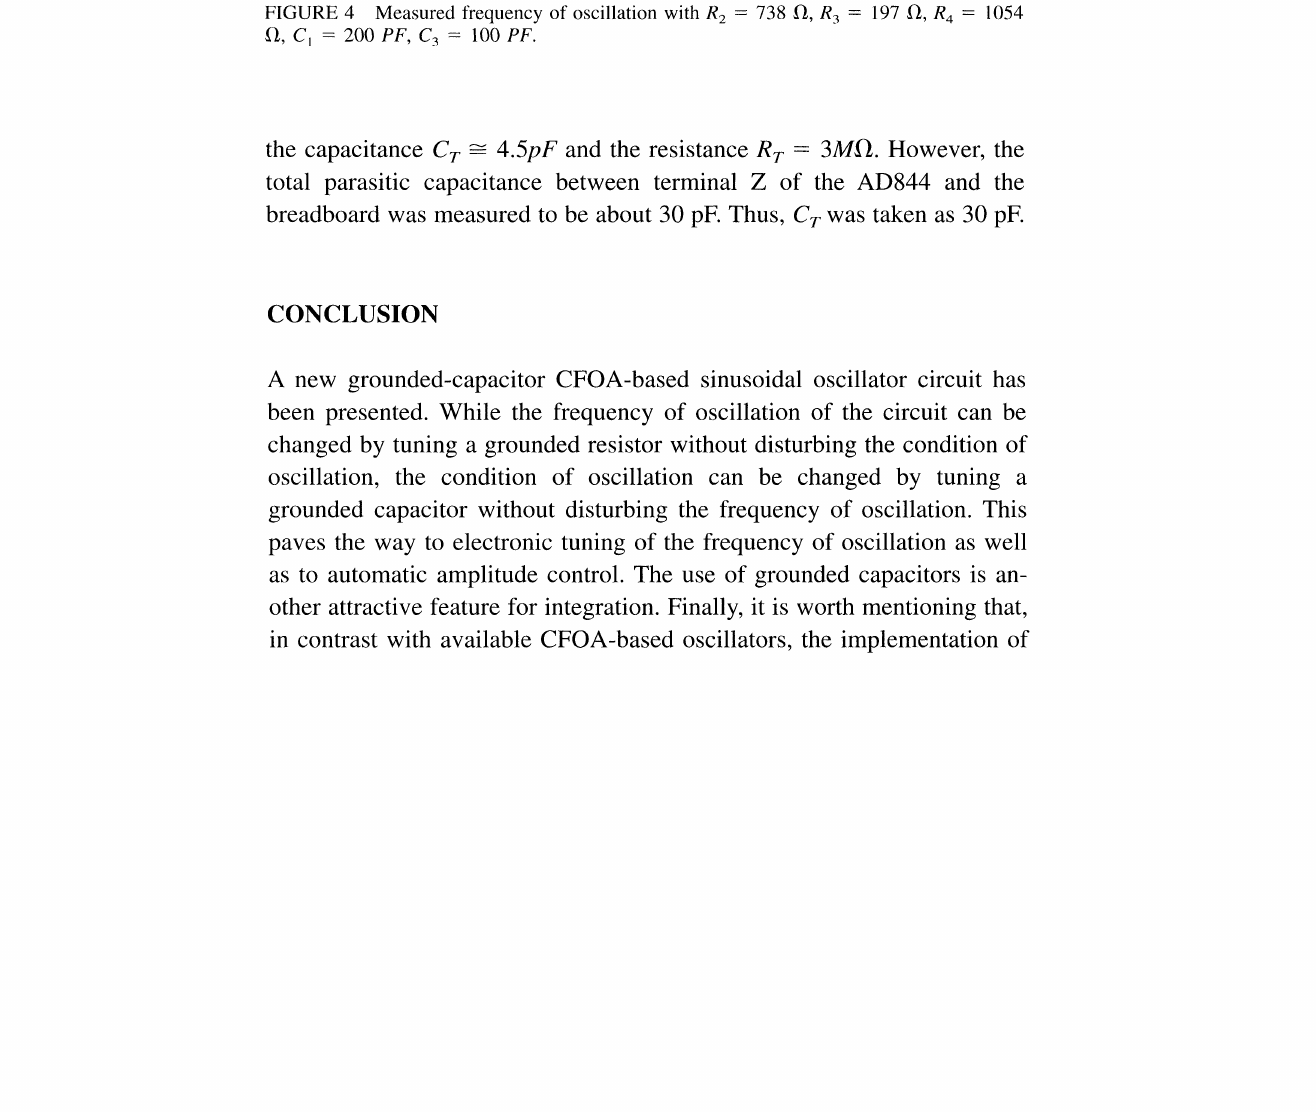
FIGURE 4 Measured frequency of oscillation with Re 738 f, R 197 2, R 1054 D, C 200 PF, C3 100